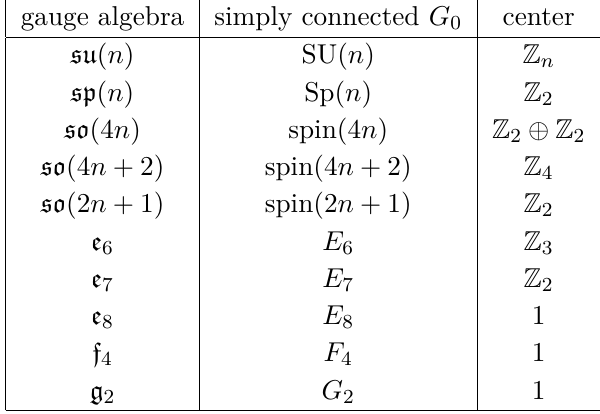
Table 1 . The discrete central subgroup of the simply connected groups associated with each gauge